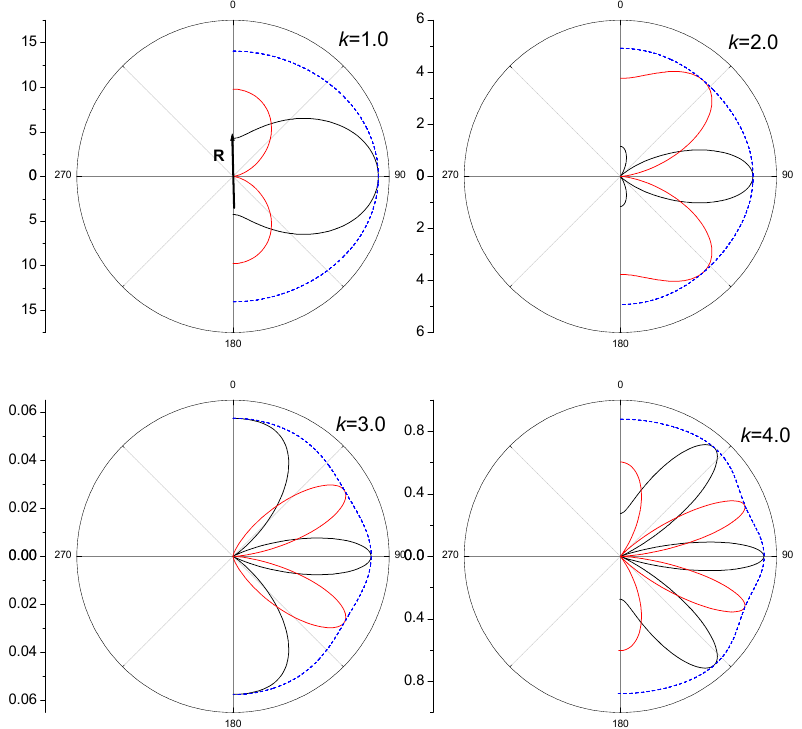
Figure 3. The partial cross-sections σ 0 ( k ) and σ 1 ( k ) (23) and their sums (12) as functions of the angle between the vectors k and R for the fixed values of k . Black solid lines are σ 0 ( k ) ; red solid lines are σ 1 ( k ) ; dotted lines are the cross-sections